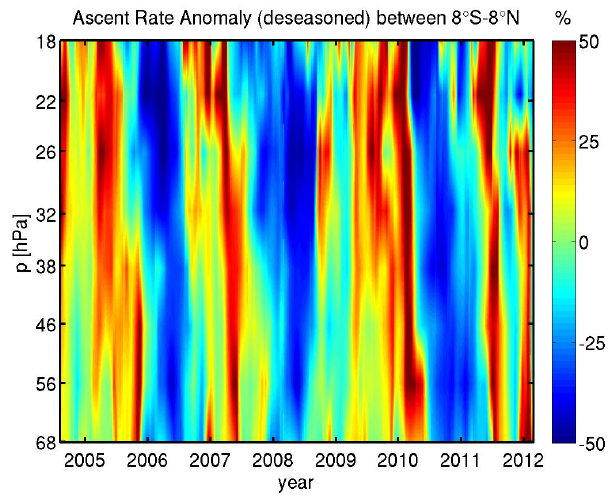
Fig. 7. Anomalies of the ascent rates shown in Fig. 6 with the seasonal cycle removed. A distinct ∼ 2 yr cycle is visible which is descending slowly at a rate of about 1.5 km month − 1 . The variability is about 50 % with lower ascent rates (blue) observed in 2006, 2008 and 2010-11. The negative anomalies occur during the QBO westerly phase as will be shown in Fig. 10. Periods of faster upwelling are indicated in red.